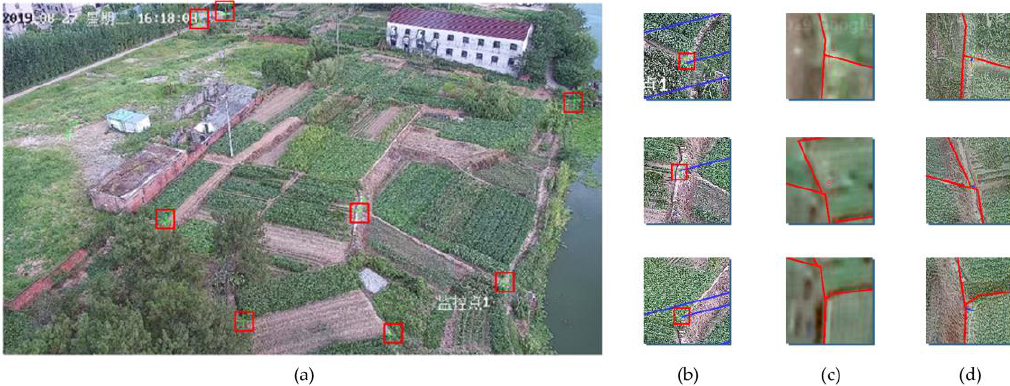
Figure 3. ( a ) The distribution of selected control points. ( b ) Local video image of selected features. ( c ) Local remote sensing image of selected features with 2D vector basic farmland protection zones (BFPZs) overlaid. ( d ) Local video image of selected features with 2D vector BFPZs overlaid. When the PTZ camera is paned, tilted, or zoomed, the homography matrix between GIS data and video frames can be calculated as follows. First, ASIFT matching method is used to detect and match features from video sequences. Then, random sample consensus (RANSAC) [29] is applied to corresponding features have mismatches even using the best automatic matching method.